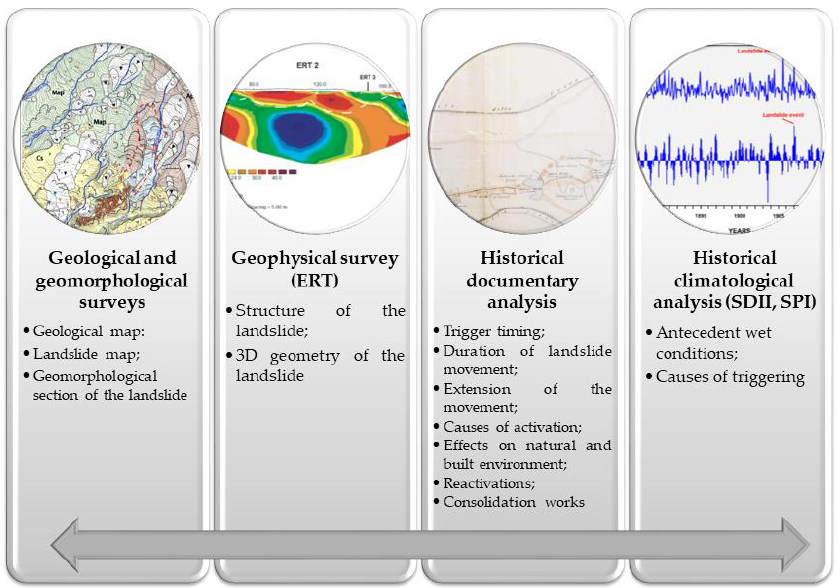
Figure 3. The four main methodological steps followed for the investigation on the historical landslide. For each step, the specific aims are itemized.